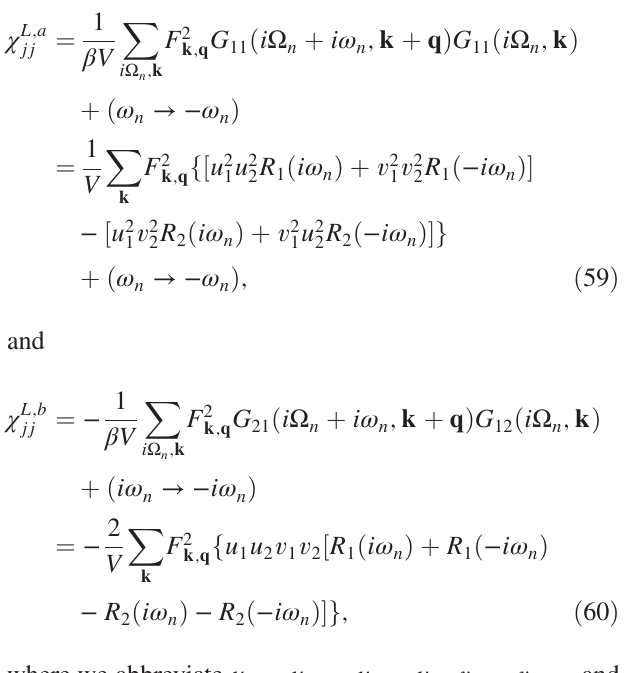
denotes the one-loop Bogoliubov approximation of Eqs. (59) and (60). The second diagram denotes the T -matrix insertion and is given by Eq.